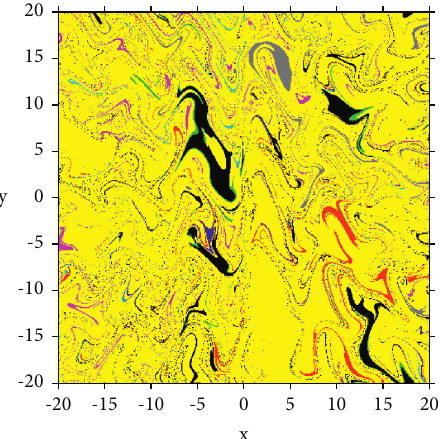
Figure 20: Basin of attraction of system (4) when [ q [ 0 . 80 , 0 . 90 , 0 . 91 ] according to the system parameters a � 1 and b � − 9 and to the initial condition of the third state variable z � 0. The colors in this figure associate with the colors of the attractors given in Figure